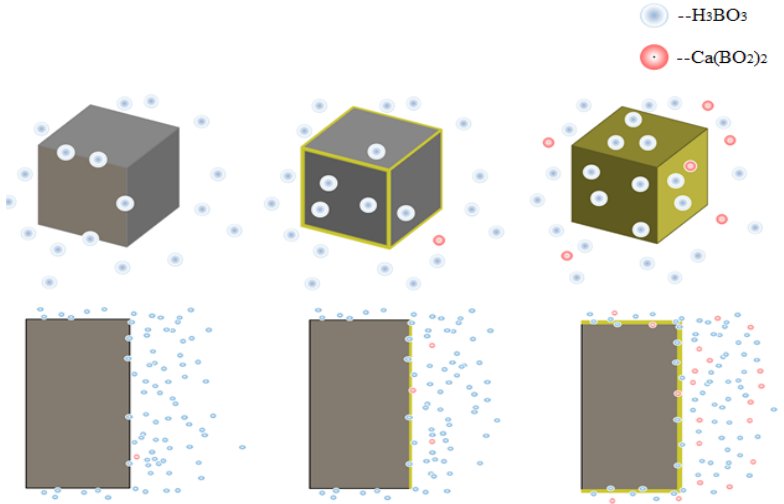
Figure 14. Corrosion mechanism of boric acid on concrete.